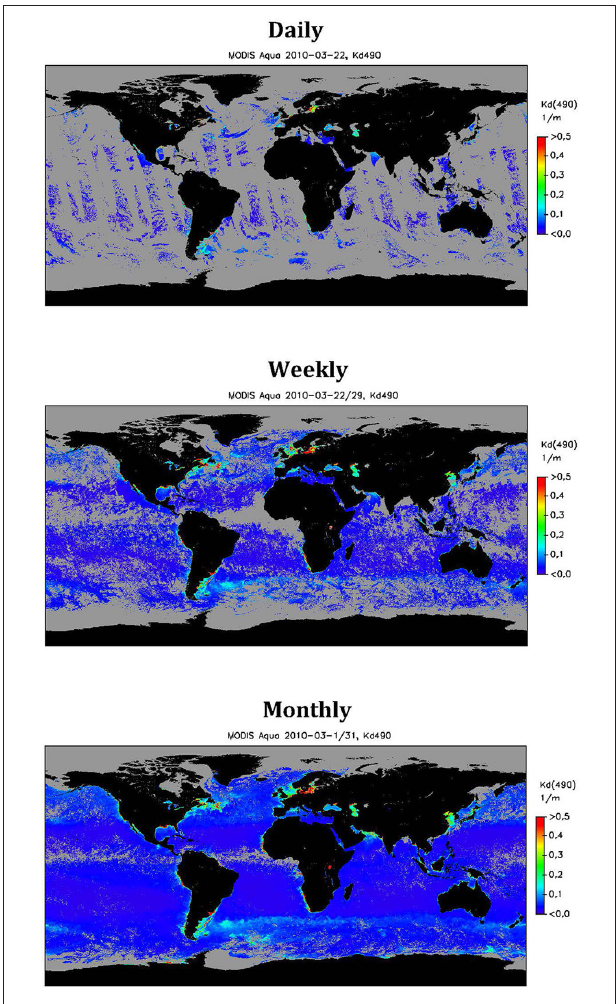
FIGURE 2 | Daily, weekly and monthly K d at 9km resolution, derived from MODIS-Aqua. Top : March 22, 2010; Middle : March 22–29, 2010; Bottom : March 1–31, 2010 (From NASA OBPG).